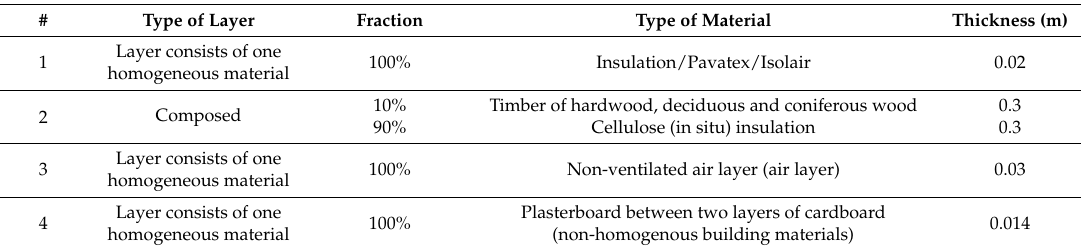
Table 11. Extracted data of composition of the pitched roof out of the